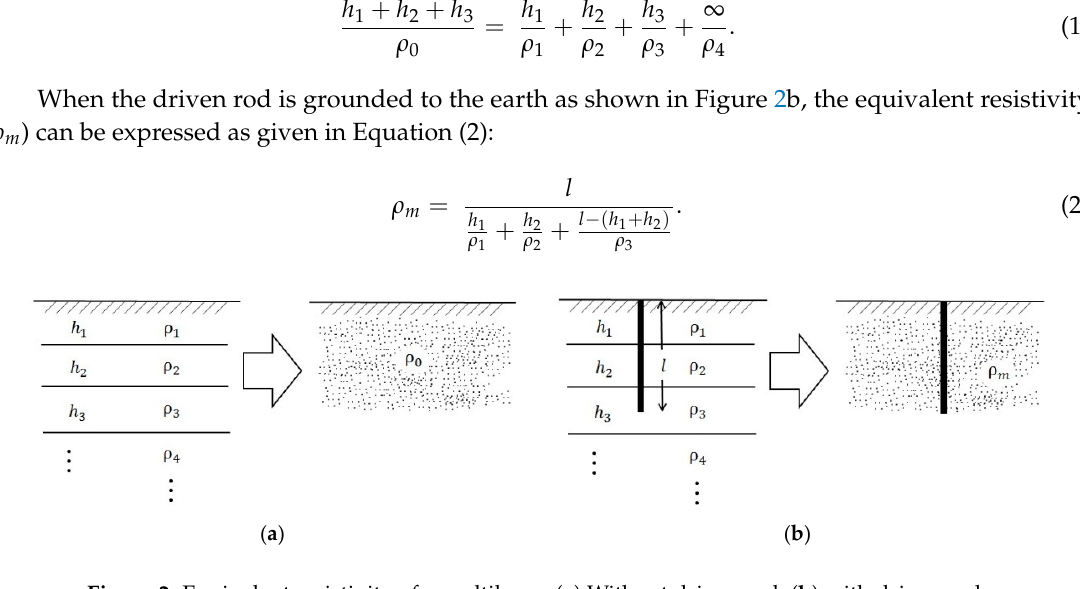
Figure 2. Equivalent resistivity of a multilayer. ( a ) Without driven rod; ( b ) with driven rod.